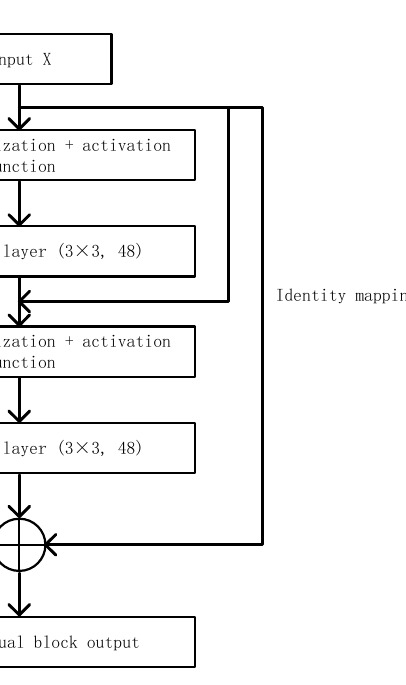
Figure 5. Dense residual block structure adopted in this paper.